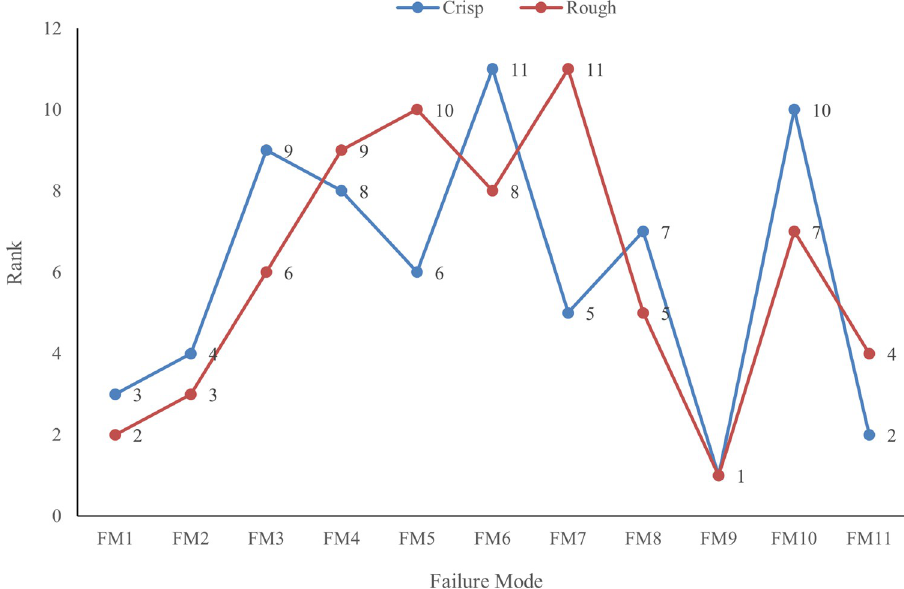
Fig 3. Ranking of failure mode using rough TOPSIS and crisp TOPSIS